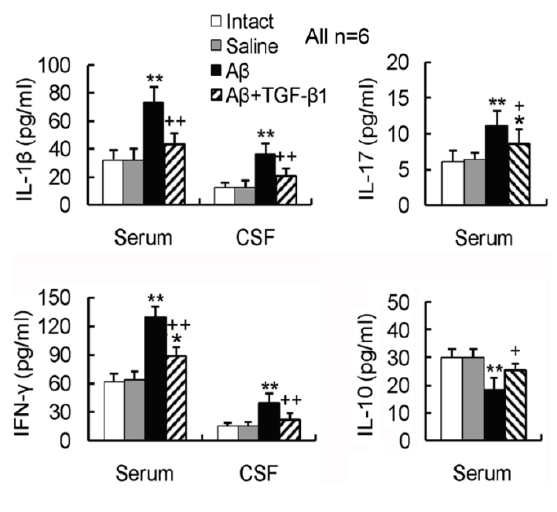
Figure 4. TGF- β 1 reverses the A β 1–42 -induced elevation of pro-inflammatory cytokines and the reduction of anti-inflammatory cytokine in serum or CSF. Concentrations of the cytokines, including pro-inflammatory IL-1 β , IFN- γ and IL-17 and anti-inflammatory IL-10 in serum or CSF, were examined by ELISA. * p < 0.05, ** p < 0.01, versus intact or saline controls; + p < 0.05, ++ p < 0.01, versus A β 1–42 injection